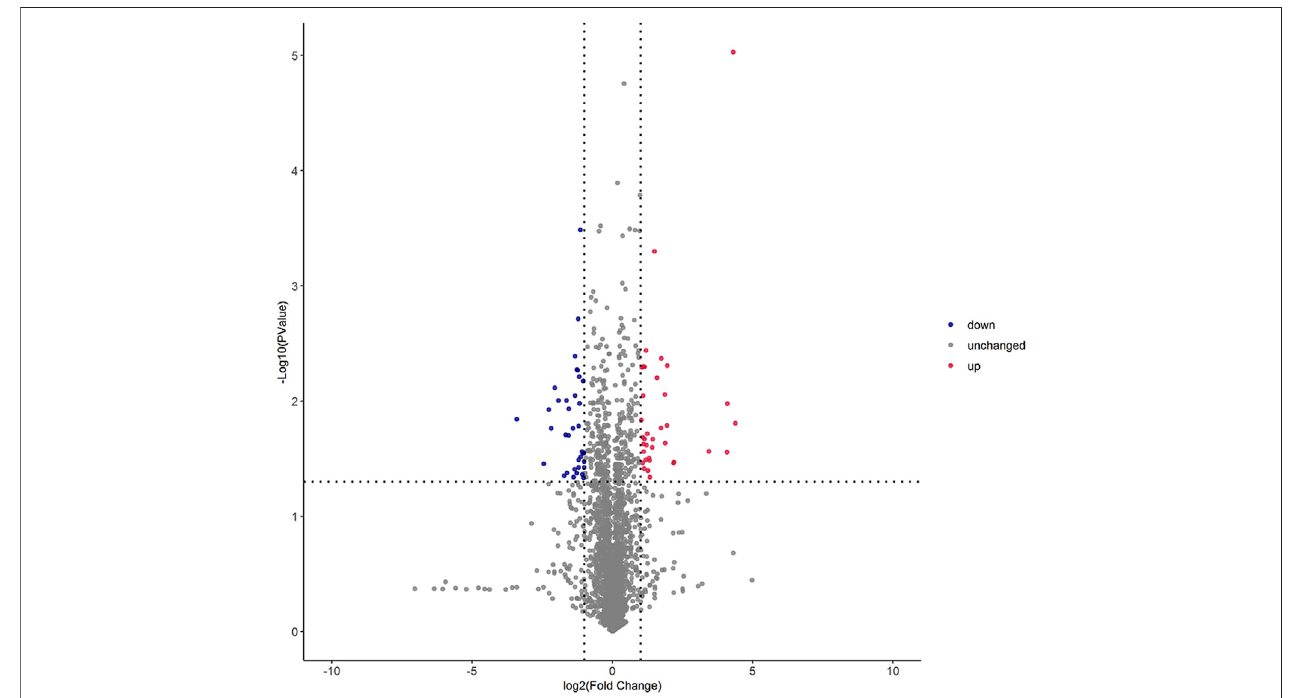
FIGURE2| Volcanographofdifferentiallipidmoleculesintwofoxtailmillet.Note:Eachdotinthevolcanoplotdenotesonelipid.Thex-axisdenotesthefoldchange ofeachsubstanceundercomparisoninthegroup(adoptinglogarithmwithabaseof2),andthey-axisdenotesthe p -valueofthe t -test(adoptinglogarithmwithabaseof 10). The scatter size denotes the VIP value of the OPLS-DA model: the larger the scatter size, the greater the VIP value, and the more reliable the differentially expressed lipidobtainedthroughscreening.Thebluespotsdenotelipidswithdown-regulated differentialexpression; theredspotsdenote lipidswithup-regulateddifferential expression; the gray spots denote the detected lipids without signi fi cant